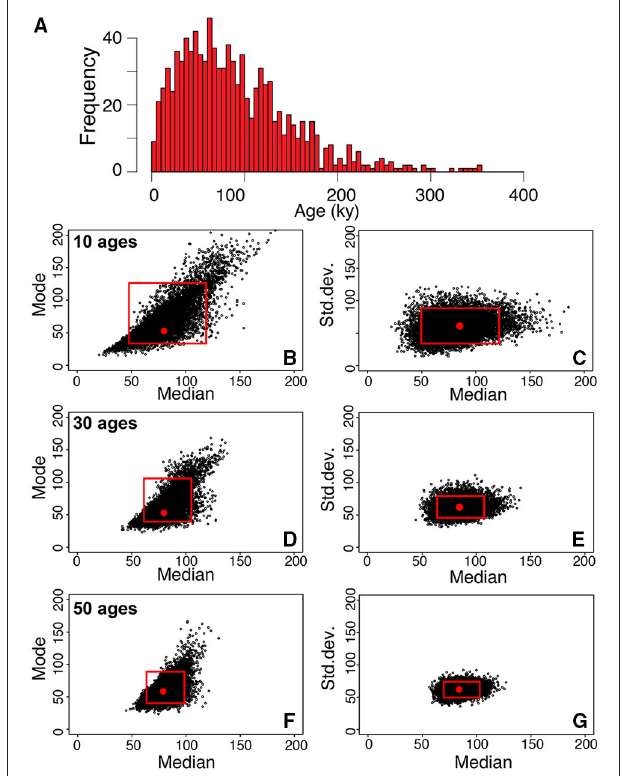
FIGURE 8 | (A) Distribution of ages characterized by a mode of 50 ky, a median of 80 ky, and a standard deviation of 60 ky. (B,D,F) Each black point in the panels shows the values of mode, median, and standard deviation obtained by bootstrapping of the population of zircon crystallization times represented in (A) . Distributions of the values of mode and median obtained by sampling the distribution reported in (A) , 10, 30, and 50 times, respectively. The procedure has been repeated 10,000 times for each subsample of 10, 30, and 50 ages. (C,E,G). Distributions of the values of standard deviation and median obtained by sampling the distribution reported in (A) , 10, 30, and 50 times, respectively. The red boxes provide the 95% confidence intervals for mode, median, and standard